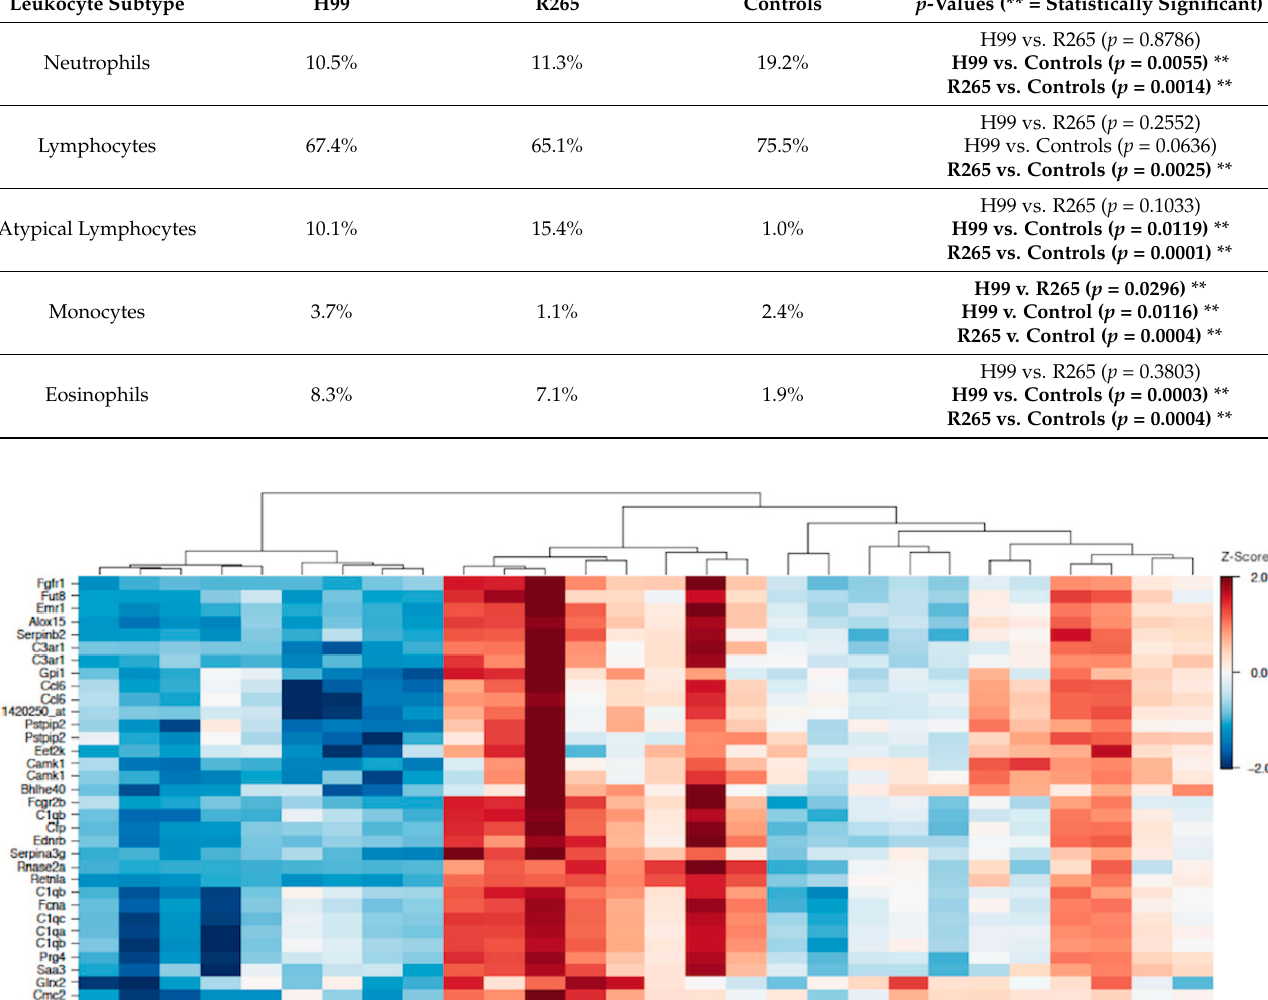
Figure 2. Variation in circulating white blood cells. Mean levels of each cell type for C. neoformans Table 1. Differences in peripheral white blood cell counts. (H99), C gattii (R265), and controls in peripheral blood samples taken at day 14 post-inoculation. Error bars indicate standard deviation. p values denote significant differences between groups.